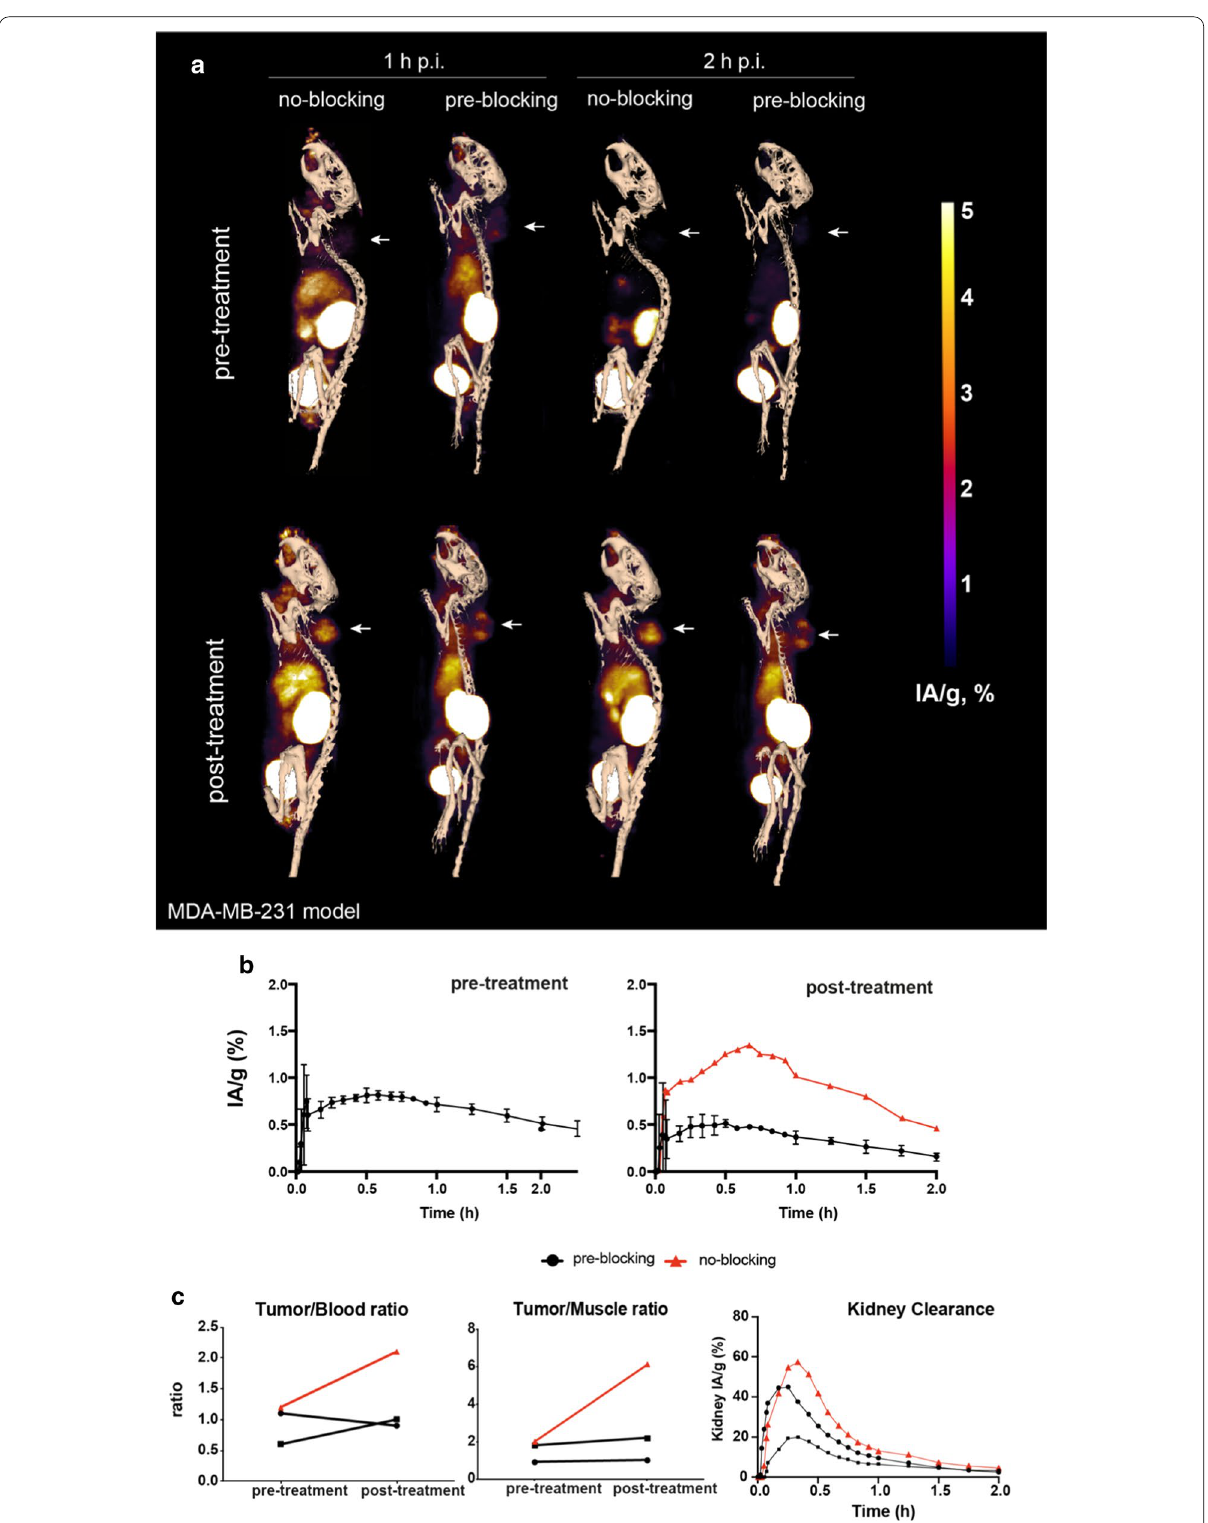
Fig. 6 Effect of pre‑blocking of PS using ( 10) molar excess of unlabeled C2Am on 18 F‑C2Am tumor contrast in MEDI3039‑treated mice (0.4 mg/ × kg, 24 h, i.v.) bearing MDA‑MB‑231 tumors. Red lined triangles ( 18 F‑C2Am; no pre‑blocking); black lined squares ( 18 F‑C2Am; 10x pre‑blocking